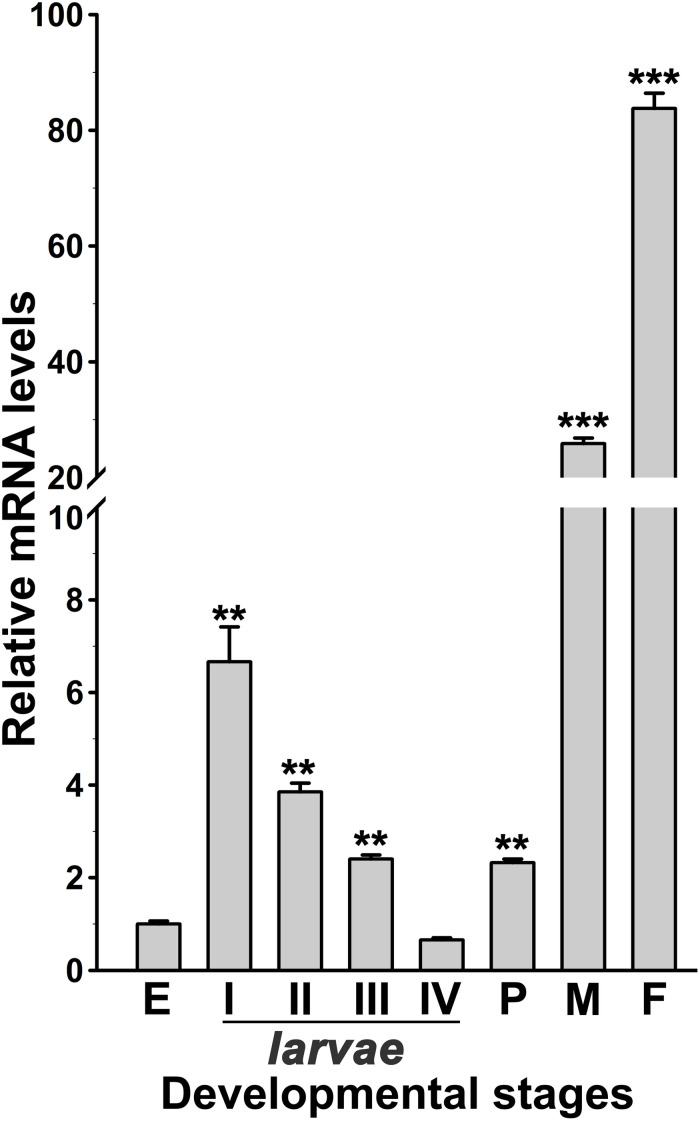
Analysis of AsHPX2 gene expression in different development stages of An. stephensi. Relative mRNA levels of AsHPX2 gene were analyzed in different stages of mosquito development against the mRNA levels of eggs, which were considered as 1.0. Significant differences (p < 0.001 or 0.01) are indicated by three or two asterisks, respectively. E, eggs; I–IV indicate different stages of instar larvae; P, pupae; M, males; F, females.